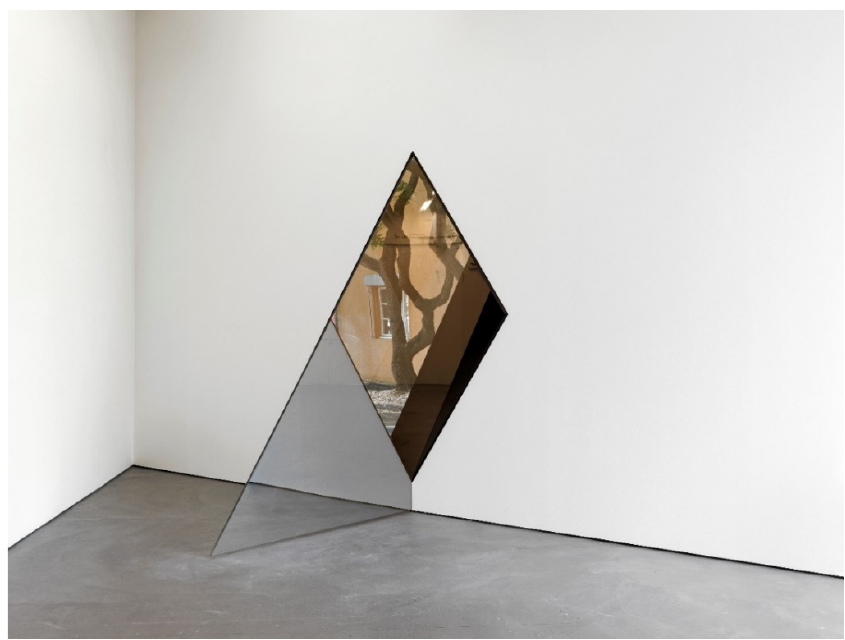
Fig. 13 33-D, 2014 | Aluminum, glass and existing architecture | Total dimensions variable | Location: Kunsthaus Baselland Photo Credit: Serge